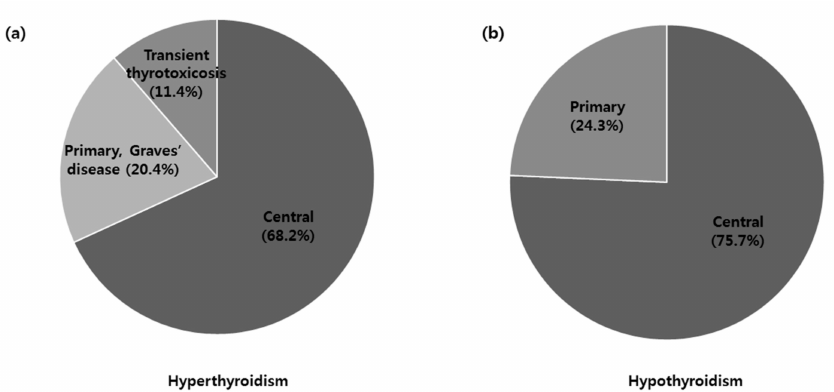
Figure 1. Classification of study subjects according to the presence of hyperthyroidism or hypothyroidism. ( a ) Among 44 patients with hyperthyroidism, 9 (20.4%) were confirmed to have Graves’ disease, and 5 (11.4%) were confirmed to have transient thyrotoxicosis. ( b ) Among 218 patients with hypothyroidism, 53 (24.3%) were confirmed to have primary hypothyroidism. The remaining patients had central hypothyroidism.